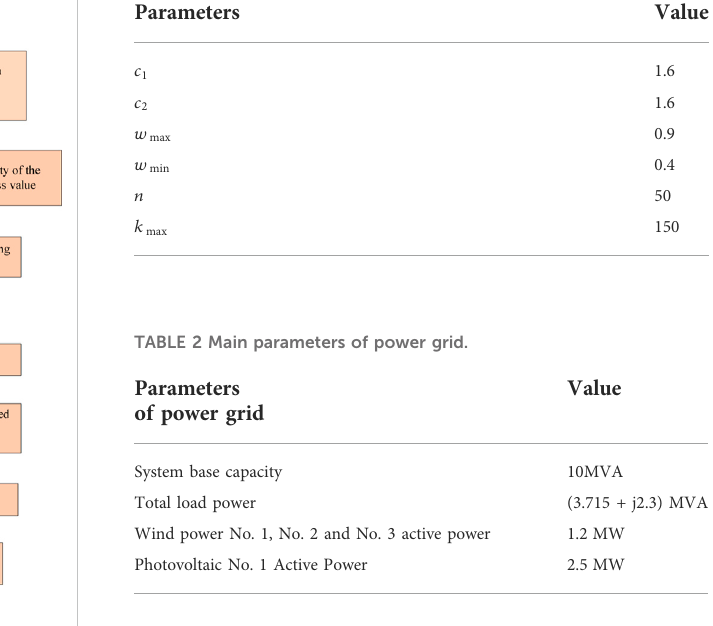
TABLE 1 MOPSO parameter setting.